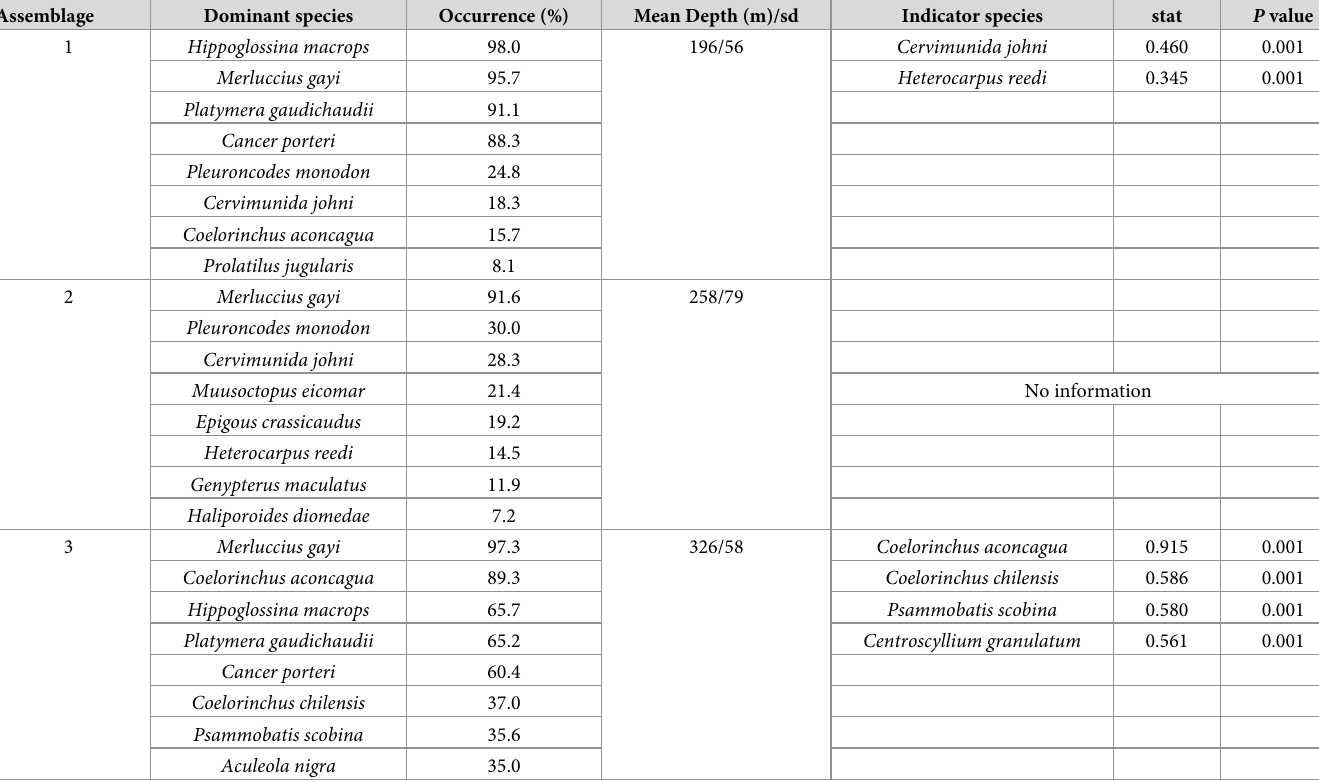
Table 2. Summary of the results of the indicator value composite index (IndVal). sd represents one standard deviation.